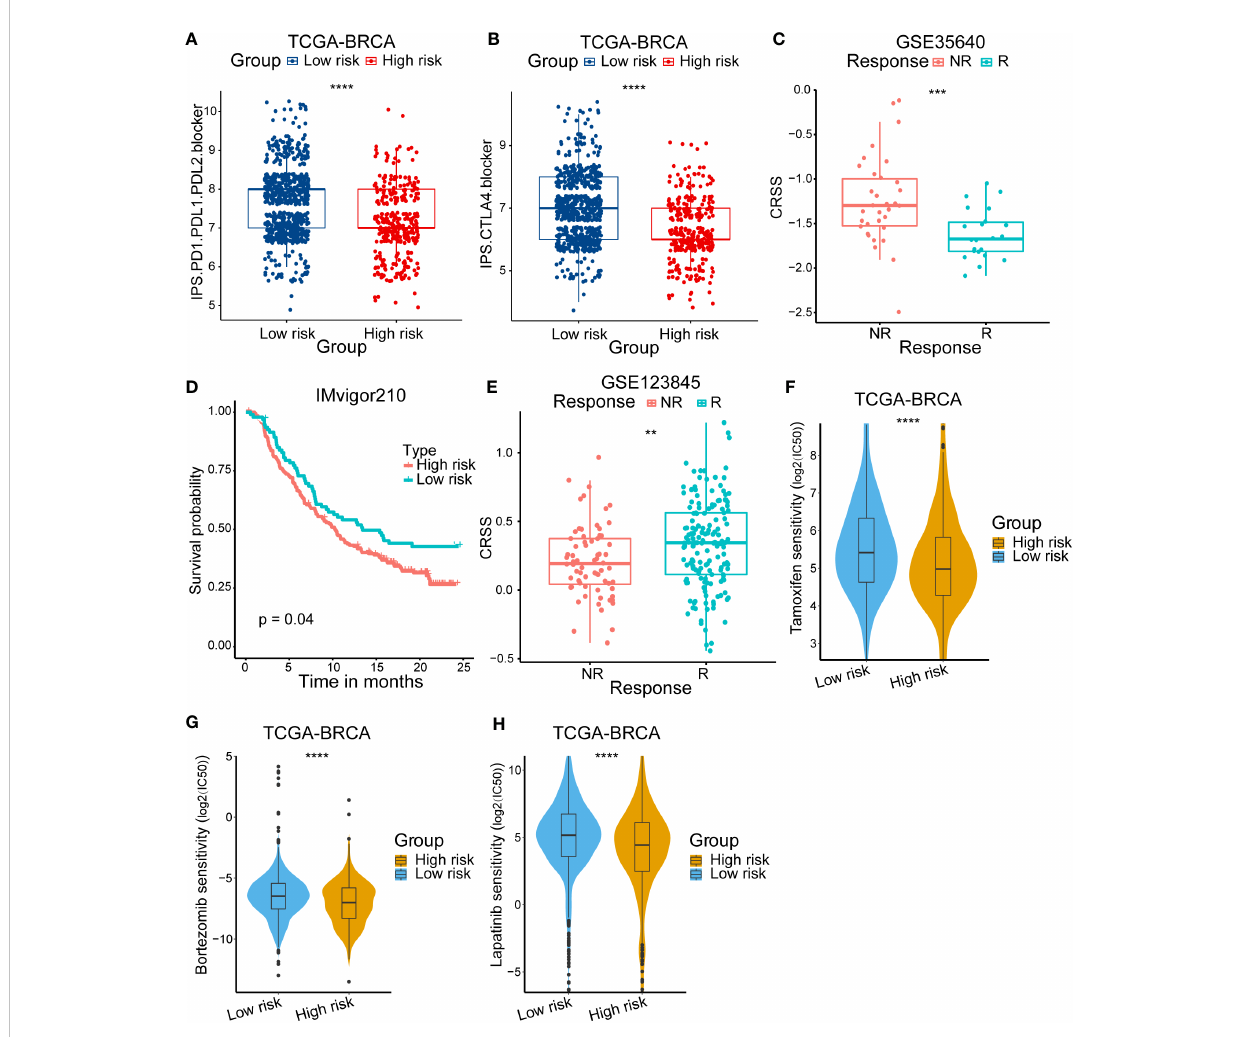
FIGURE 7 Validation of immunotherapy response and the difference of anticancer drug sensitivity. (A, B) Immunophenoscore (IPS) score in high/low-risk subgroups. (C) Kaplan – Meier survival curve of the patients in high/low-risk groups for OS in the PD-1/PD-L1 treatment cohort (IMvigor210). (D) Analysis of the immunotherapy response between high/low-risk groups in the high-grade melanoma immunotherapy cohort (GSE35640). (E) Analysis of the neoadjuvant chemotherapy between high/low-risk group in breast cancer cohort (GSE123845). (F) The IC50 of Tamoxifen among high/low-risk groups. (G) The IC50 of Bortezomib among high/low-risk groups. (H) The IC50 of Lapatinib among high/low-risk groups. The asterisks represent the statistical P value (**p < 0.01; ***p < .001; ****p <